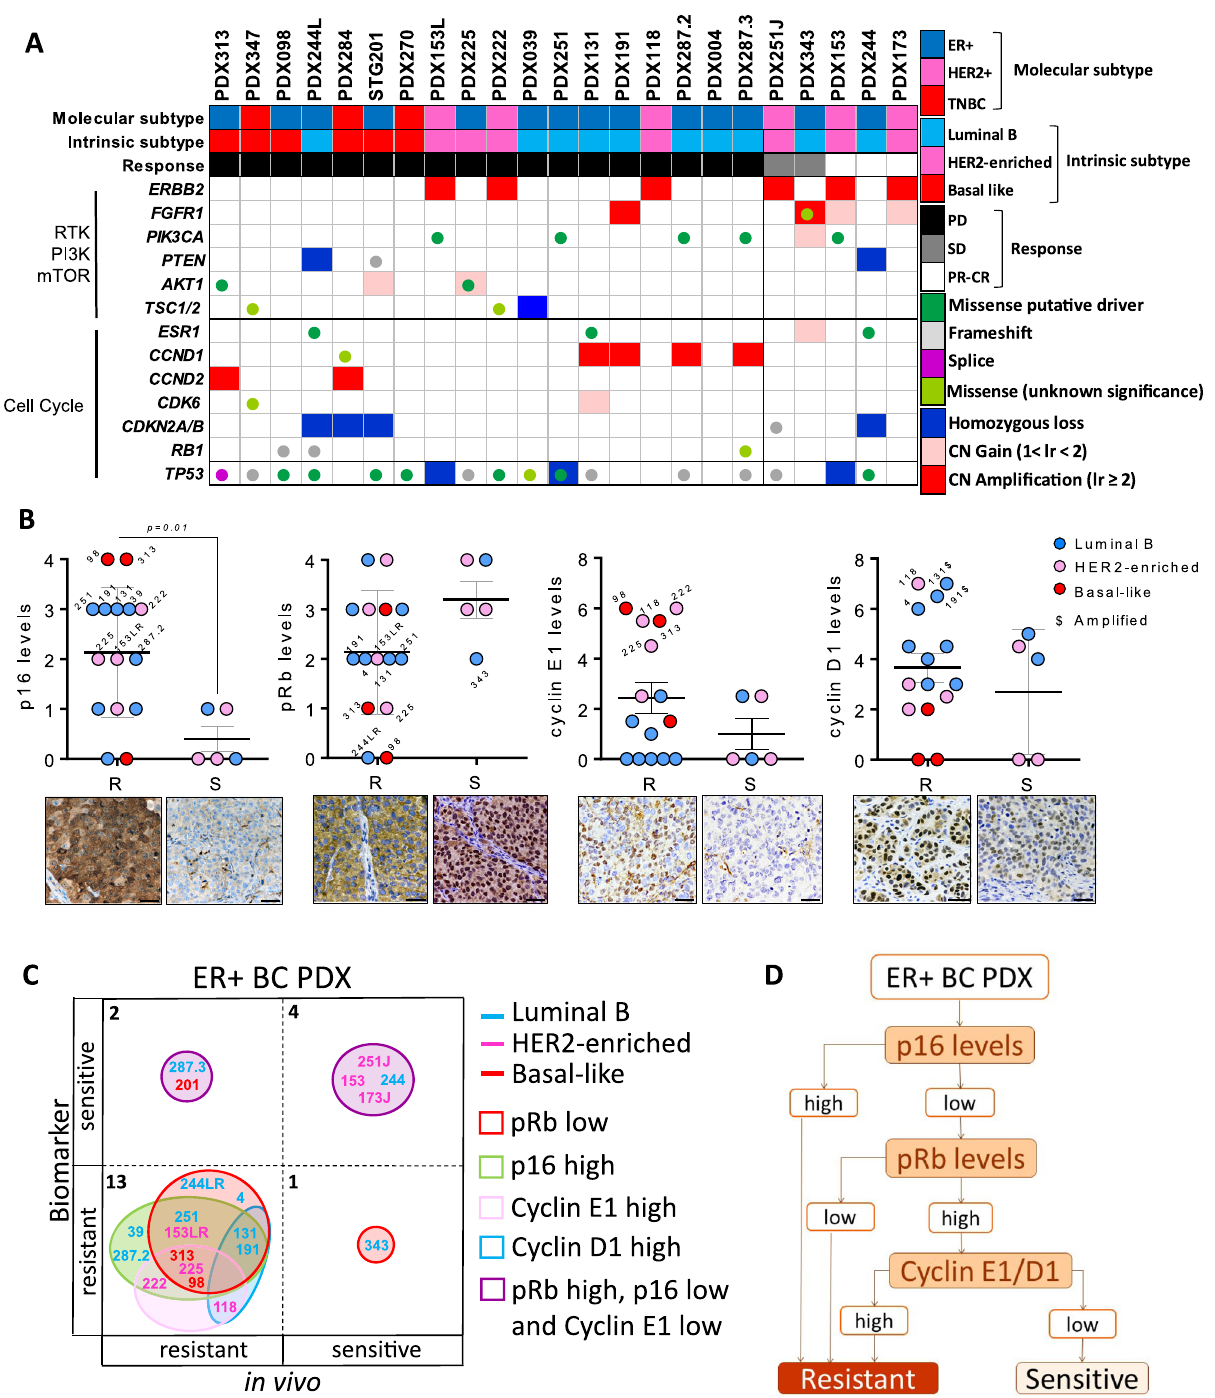
Fig. 2 | PDXs expressing high p16 are resistant to ribociclib. A Summary of genetic alterations in the PDX panel from Fig. 1B, including the PDX subtype classi fi cation, based on IHC (molecular subtype) or PAM50 analysis (intrinsic subtype), and the response to CDK4/6 inhibitors. Genes with similar function such as TSC1/TSC2 or CDKN2A/CDKN2B were considered as one single feature. B Quanti fi cation of IHC staining for p16, pRb, cyclin E1 and cyclin D1 in n